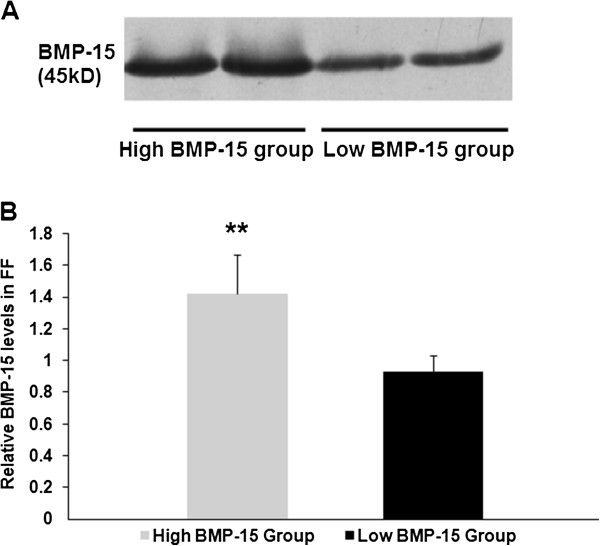
Relative BMP-15 levels in poor responders.A: Western blotting analysis of the BMP-15 protein in follicular fluid. The BMP-15 in 0.4 μl of FF following SDS gel electrophoresis, transfer and blotting on a nitrocellulose membrane with a polyclonal antibody. B: Comparison of the relative levels of BMP-15 in follicular fluid by western blotting analysis in poor responders. The level of follicular fluid BMP-15 in the high BMP-15 group was significantly higher than that in the low BMP-15 group (**P < 0.001).